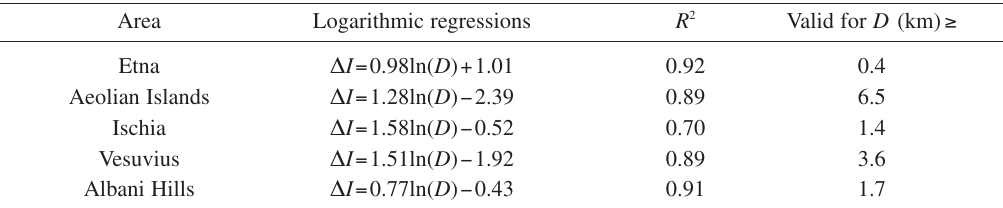
Table V. Summary of intensity attenuation laws obtained in this study. Area Logarithmic regressions